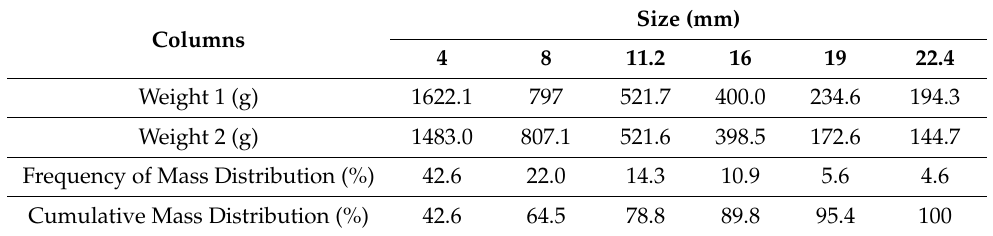
Table 5. The results of lab Table 3. The frequency of rock mass distribution of images 1 to 5.